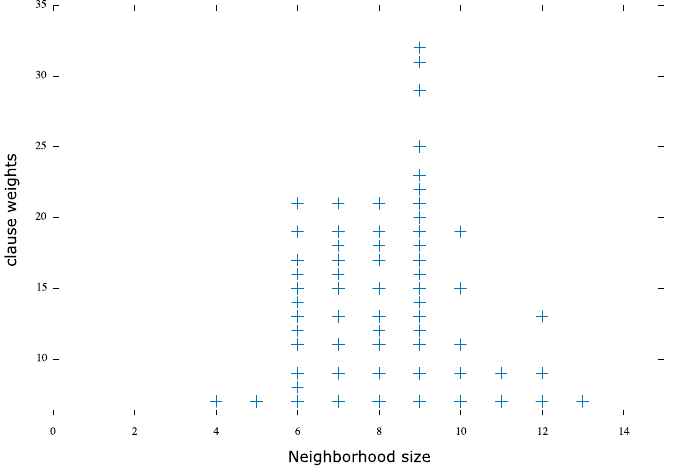
Figure 2. The figure illustrates the most weighted clauses and their corresponding neighborhood size for the aim problem set (30 instances), where the overall average of the neighborhood size is ≈ 7.5. jnh problem set: jnh was of particular interest as the correlation between the clause weights and their corresponding neighborhood sizes was very explicit. Figure 3 illus- trates the correlation, as most weighted clauses, specifically 21% of the clauses, had a small neighborhood size 79% of the clauses were the least weighted clauses with a large neighborhood size.